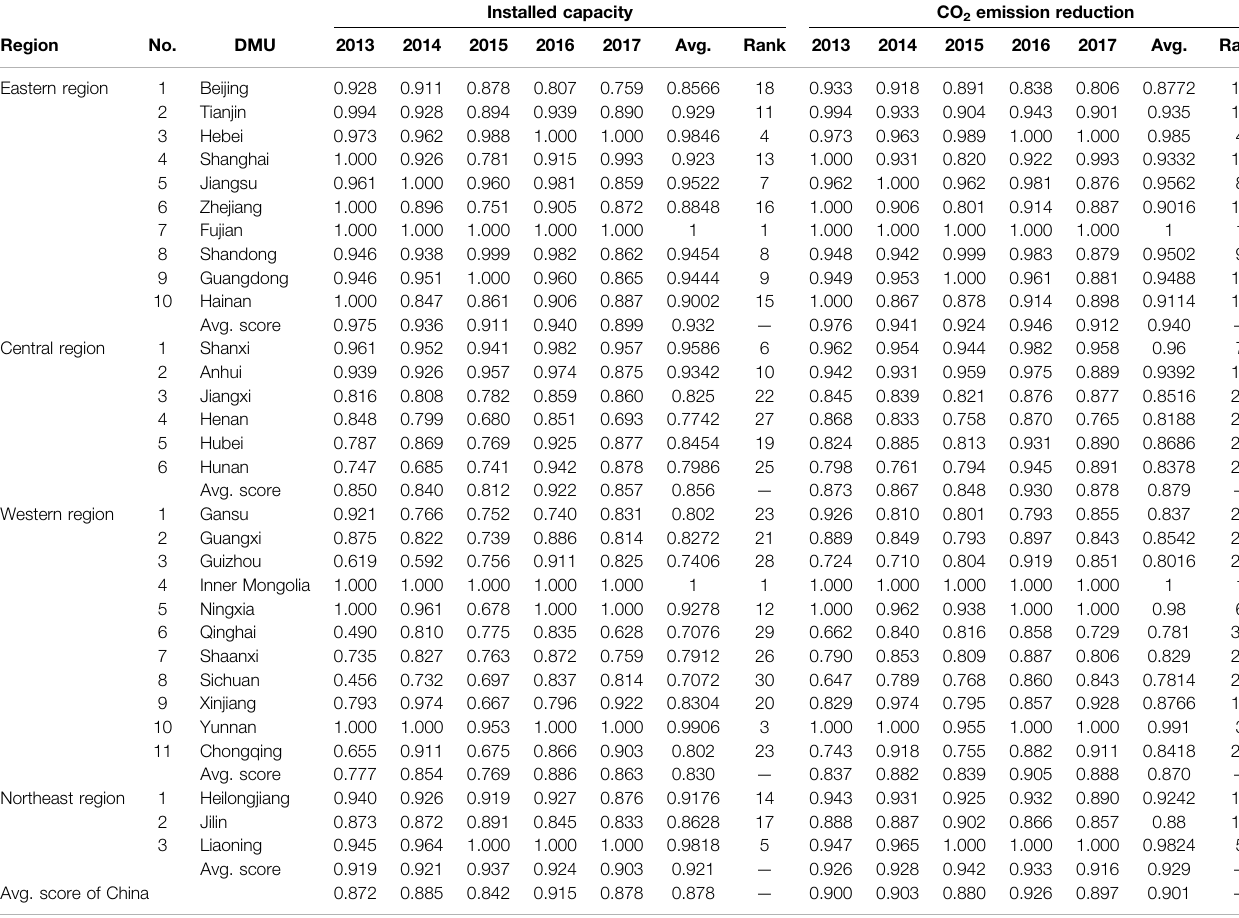
TABLE 7 | 2013 – 2017 Installed ef fi ciency and CO 2 emission reduction ef fi ciency score.